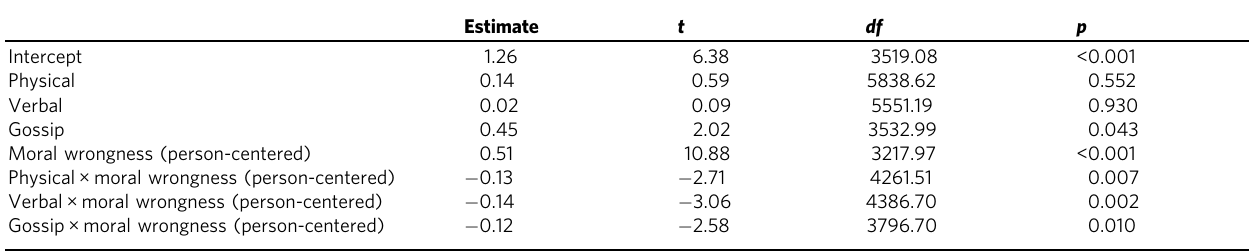
Table 2 Moral wrongness of norm violations and endorsement of punishment